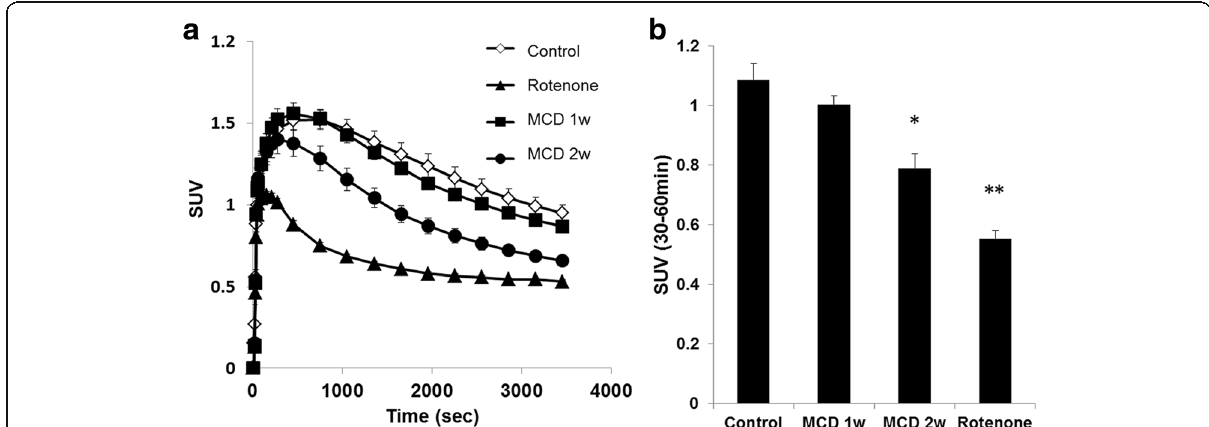
Fig. 5 Hepatic radioactivity after 18 F-BMS injection in mice fed a control or methionine- and choline-deficient (MCD) diet. Rotenone (1 mg/kg, i.p.) were injected into control mice 20 min before 18 F-BMS injection. a Time-activity curve of 18 F-BMS in control mice, MCD diet mice, and rotenone pre-injection mice. b SUV in control mice, MCD diet mice, and rotenone pre-injection mice. n = 6 – 7 mice per group. * p < 0.05 and ** p < 0.01 compared with the control